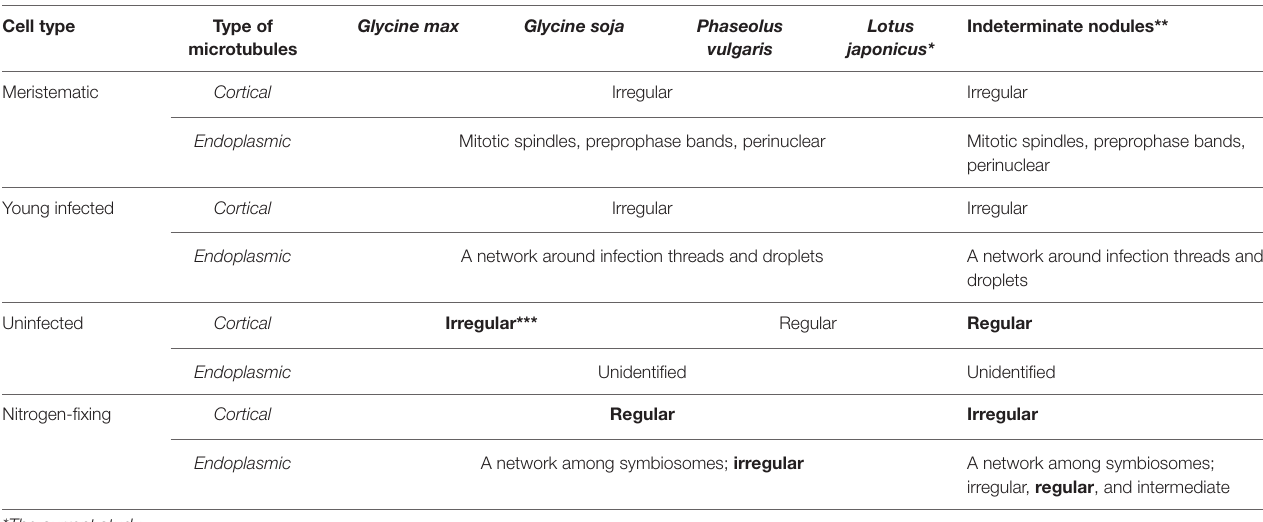
TABLE 1 | Comparative analysis of microtubular patterns in determinate nodules of G. max , G. soja , P. vulgaris , L. japonicus , and indeterminate